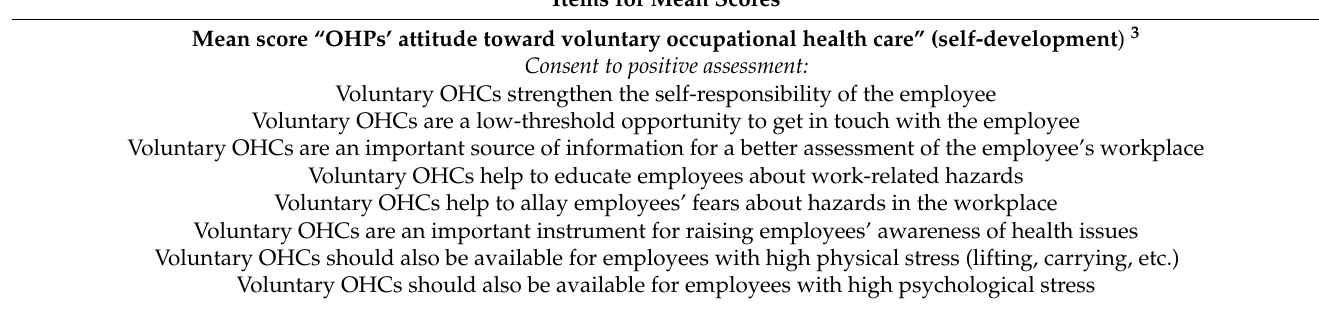
Items for Mean Scores